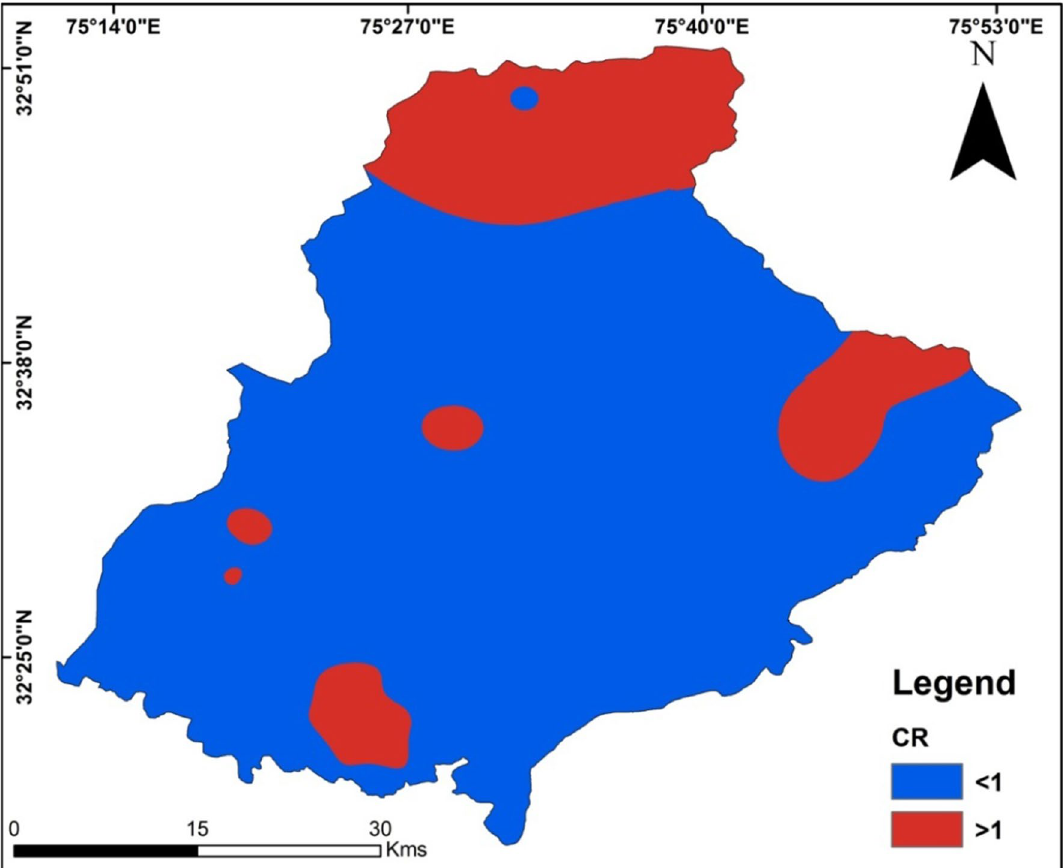
Fig. 10 Map showing spatial distribution of the